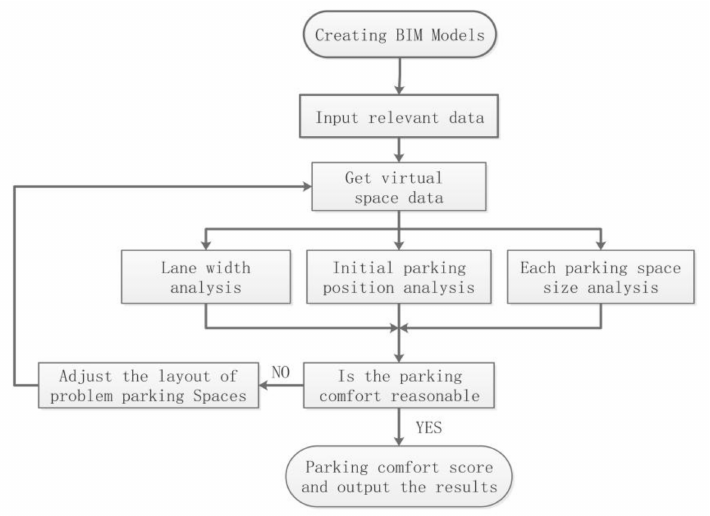
Figure 6. Development flow chart of the quantitative analysis program for parking comfort.